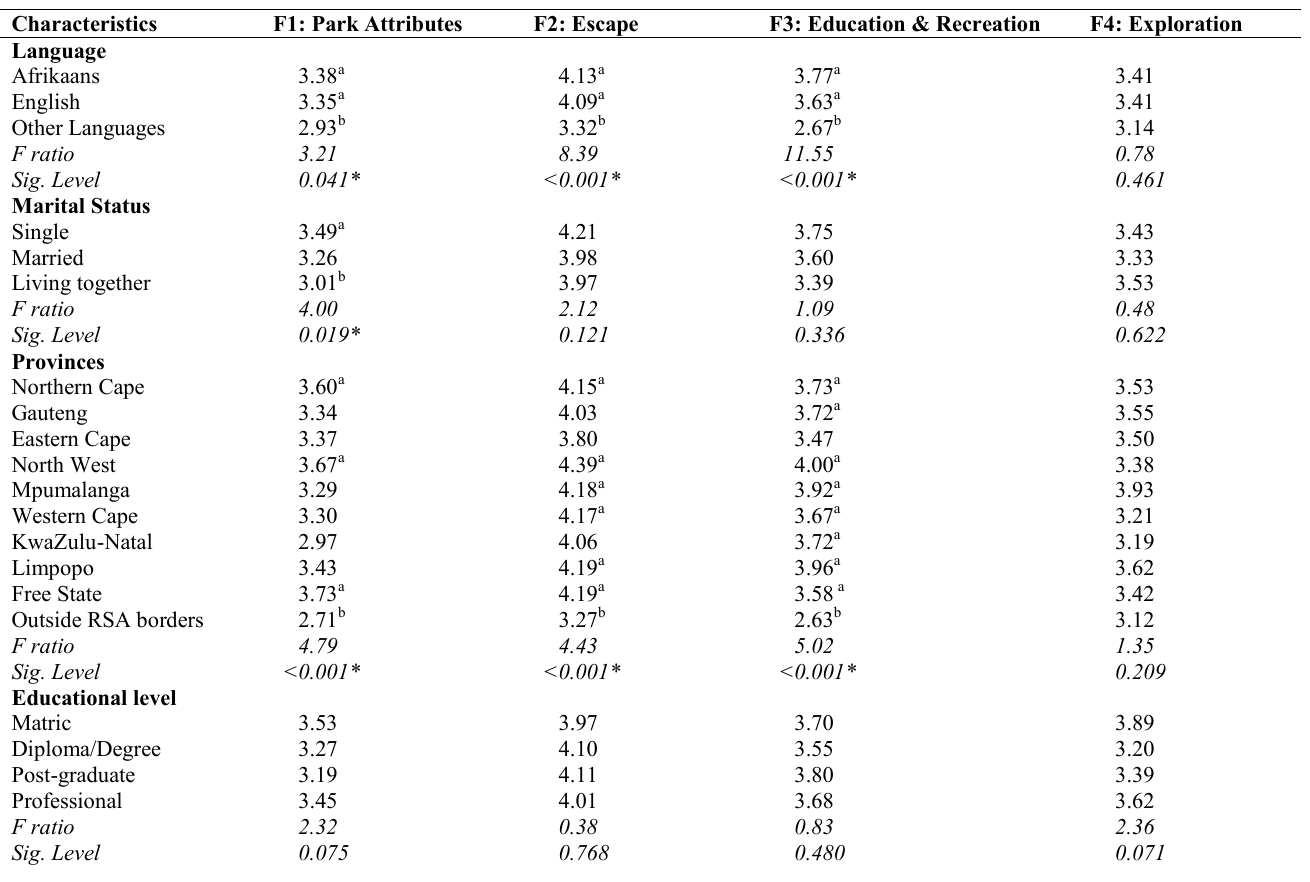
Table 5: Results of ANOVA multiple comparisons for visitor characteristics ( n = 414)